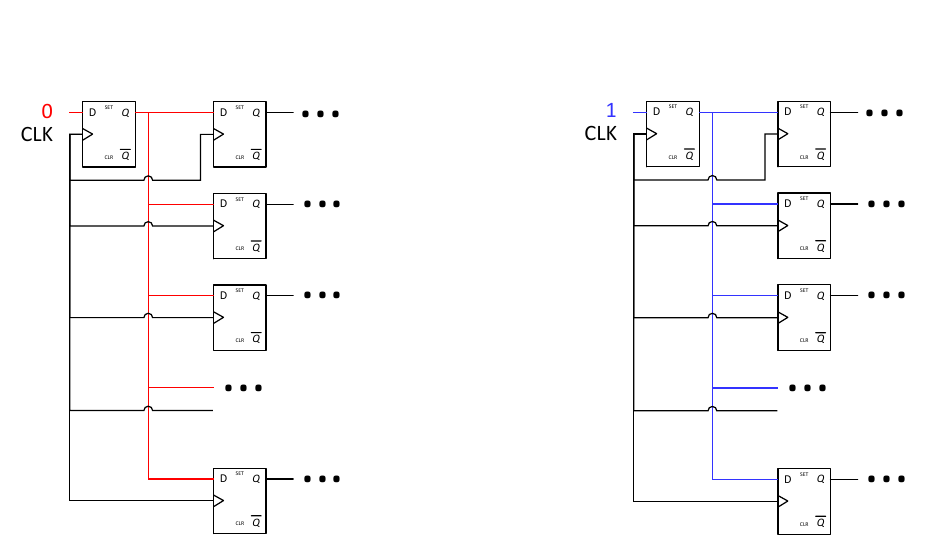
Figure 2: Exemplary depiction of a single bit saved in the high-fanout register, either set to 0 (left) or to 1 (right). The average fanout per first stage flip-flop is 11.